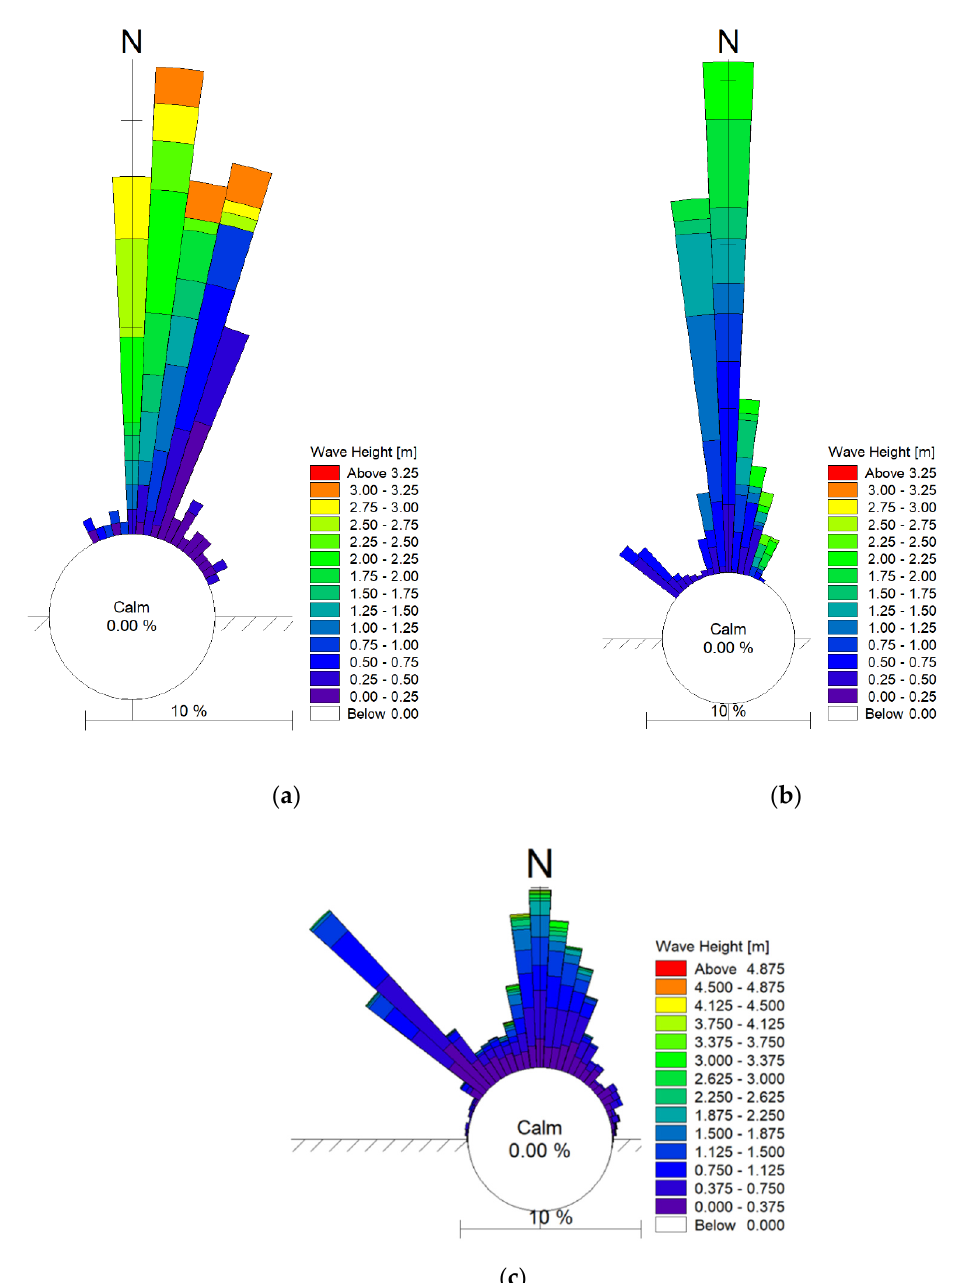
Figure 4. Wave height rose plot for the dataset containing records of 7 days ( a ), 20 days ( b ) and a year of data ( c ).